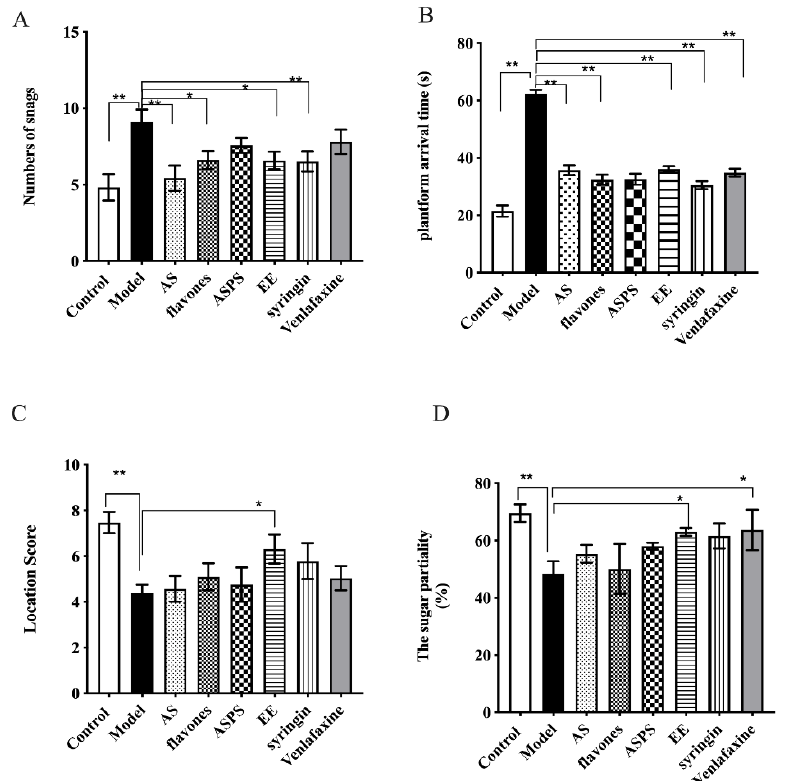
Figure 1. The completion of water maze in each group of mice. ( A ) The number of snags of each group; ( B ) the platform arrival time; ( C ) the location score; ( D ) the sugar partiality of each group ( n = 8 per group, * p < 0.5, ** p < 0.01, significant differences between the groups were tested by one-way analysis of variance).